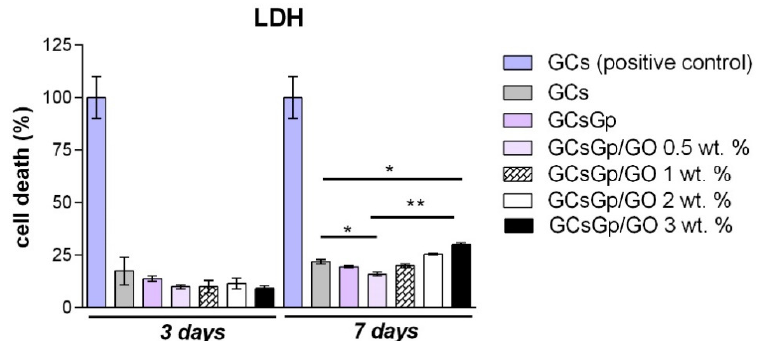
Figure 6. GCs and GCsGp/GO scaffolds’ cytotoxicity evaluation by LDH assay during 7 days of in vitro cell culture. Statistical significance: *— p < 0.05; **— p < 0.01.